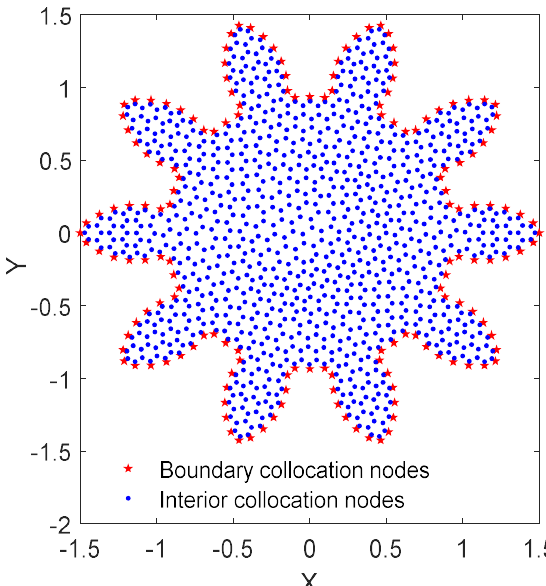
Figure 12. Distribution of 1186 collocation nodes.